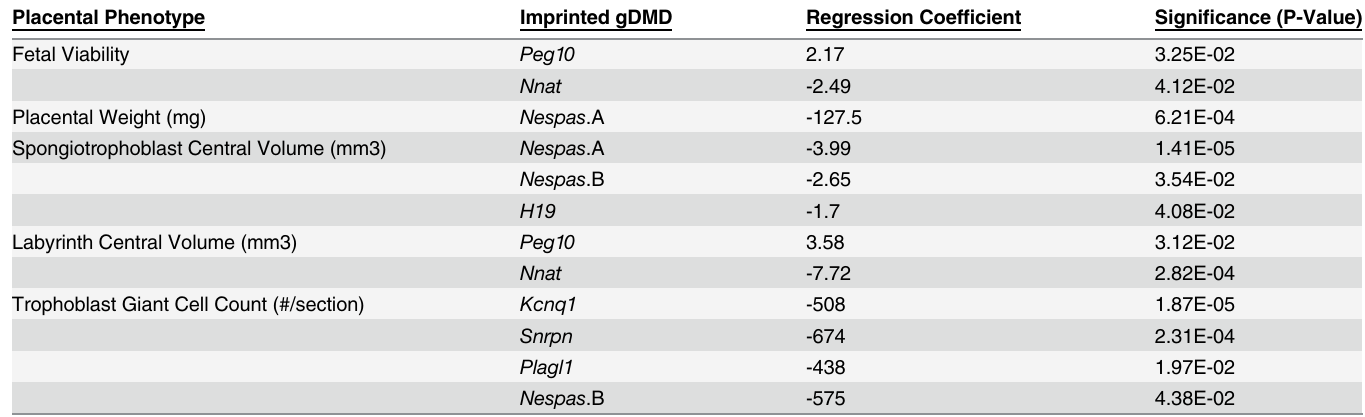
Table 2. Bivariate regression analysis of E12.5 DNMT1o-deficient placentas based on gDMD methylation and placental phenotypes. Only signifi- cant (P < 0.05) associations established by bivariate regression analysis between dependent placental phenotypes and independent imprinted gDMD methyl- ation values are shown. Regression coefficient is either the logit (log odds ratio) for logistic regression for fetal viability, or the linear regression coefficient ( β ) for all other variables.